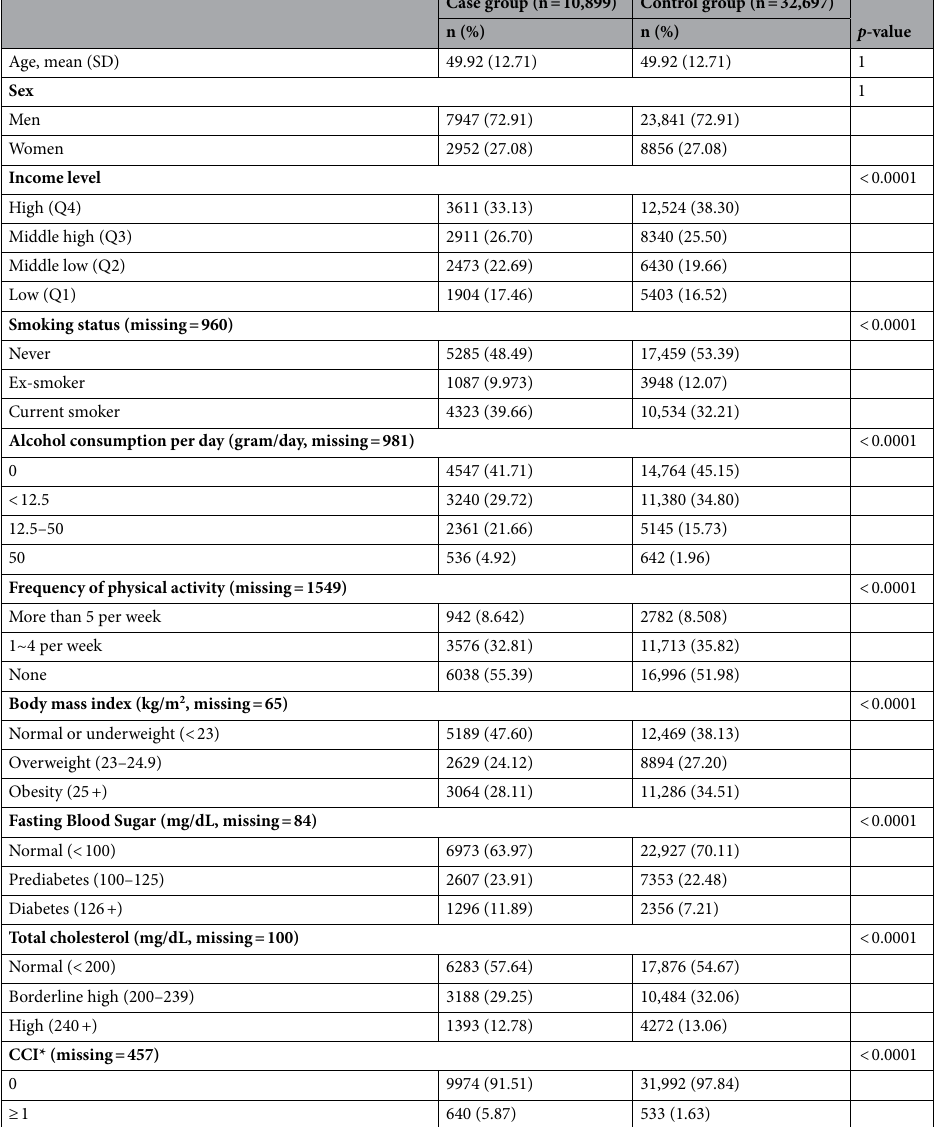
Table 1. Baseline characteristics of the study population in 2002–2003 based on the case and control groups. *CCI, Charlson Comorbidity Index, among inpatients only at baseline in 2002–2003. SD standard